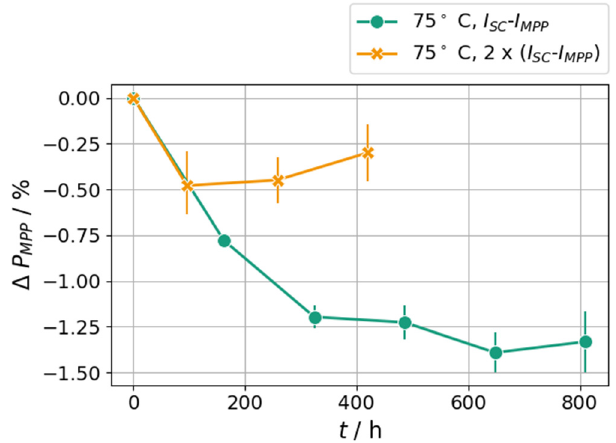
Fig. 8. Relative changes of P MPP at STC of PV modules during LETID testing at 75 ° C (M04, M05) and at 85 ° C (M10, M11) and MPP mode. Average values over two modules; Error bars: min/ max values of two modules.